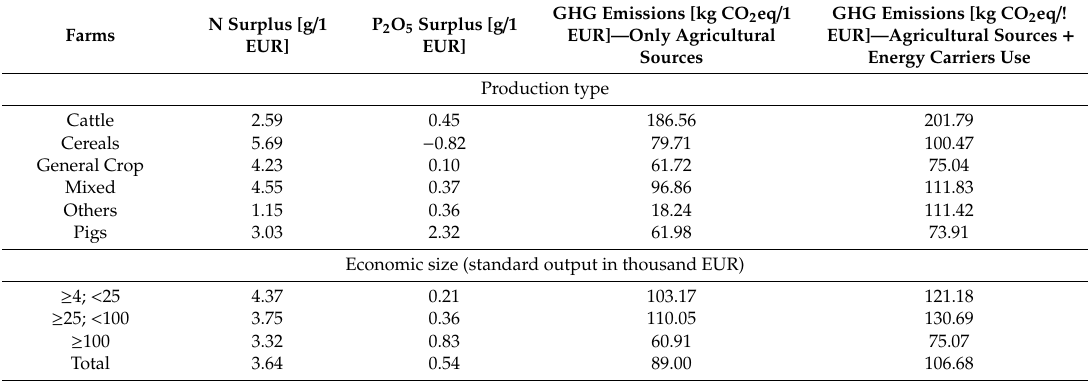
Table 3. Nitrogen and phosphorus surpluses and GHG emissions per 1 EUR of agricultural production by farm type and economic size in the sample of Polish commercial farms.